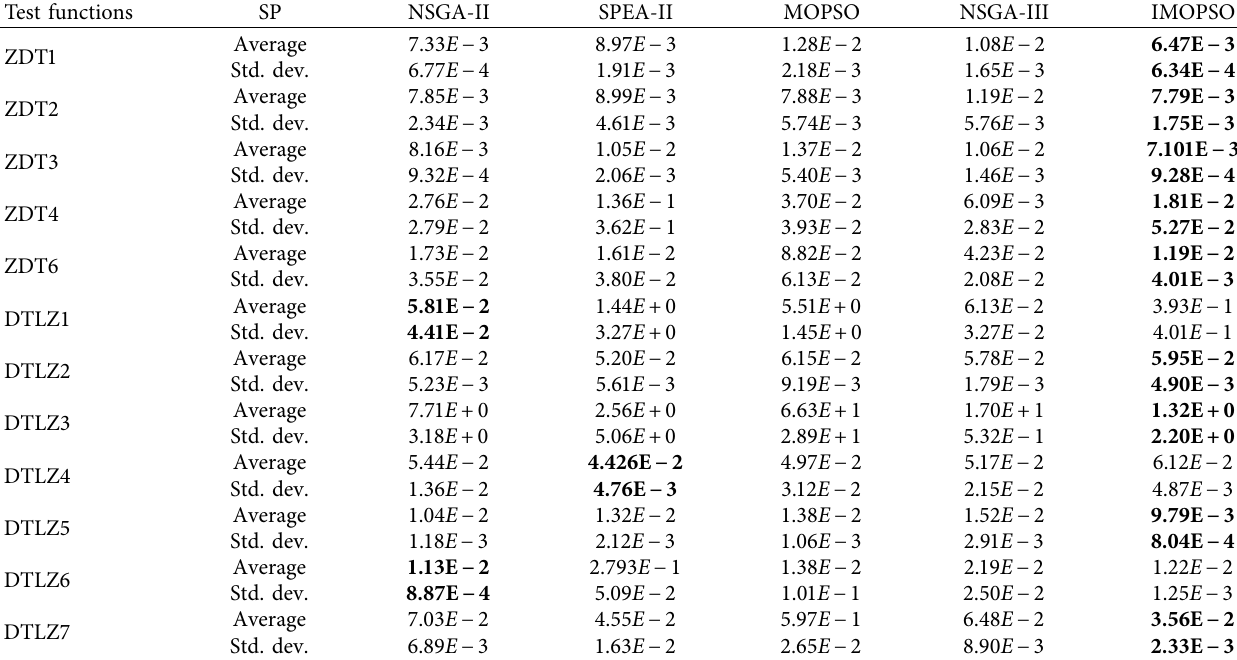
Table 6: Statistical results of SP obtained by different methods for different test functions. Test functions